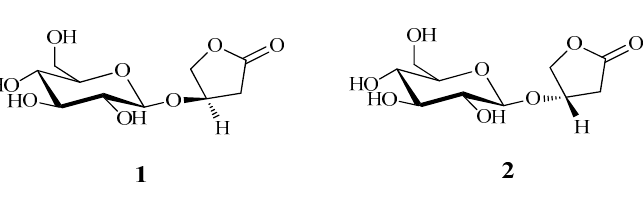
Figure 1. Structures of compounds 1 and 2